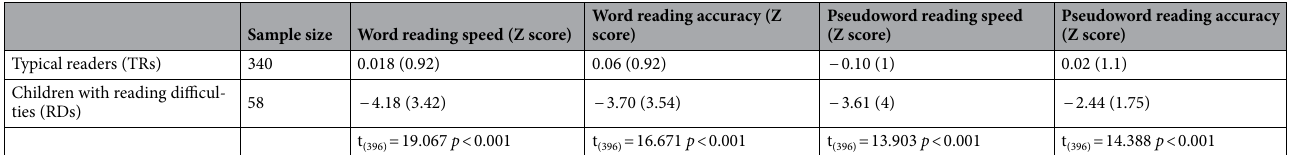
Table 2. Reading performance (means and standard deviations in Z score) in typical readers (TRs), children with reading difficulties (RDs) and reading performance differences between the two